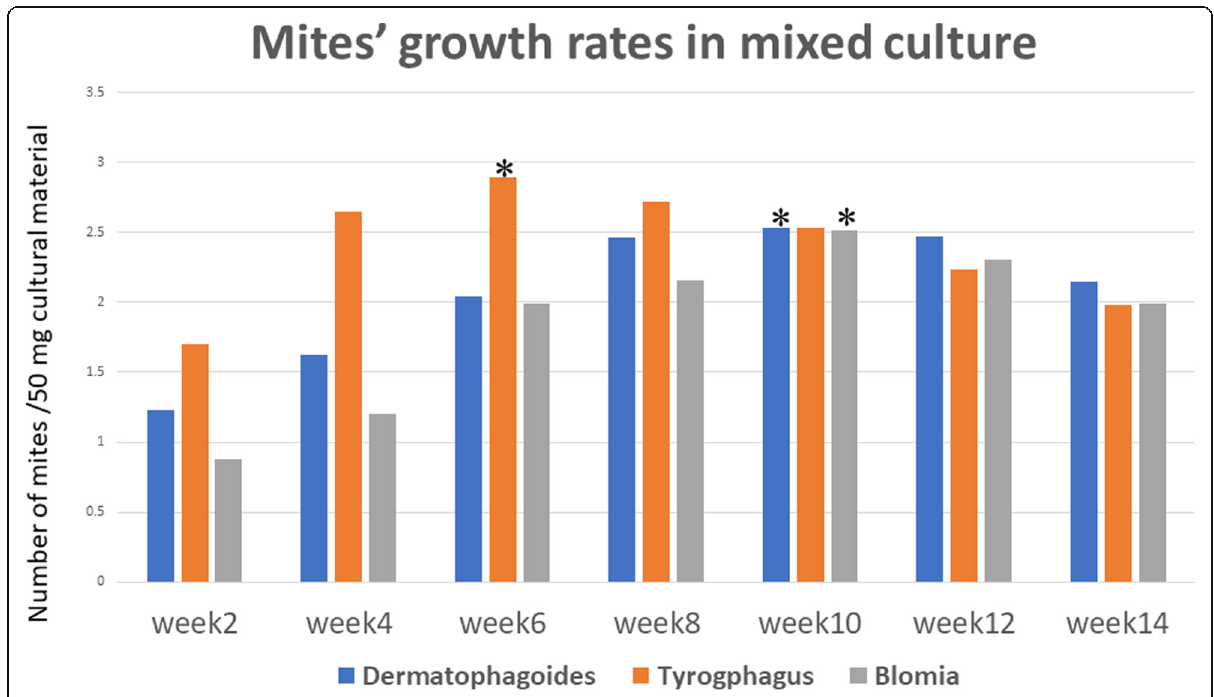
Fig. 4 Growth kinetics of Dermatophagoides , Tyrophagus , and Blomia spp. in 50-mg samples from mixed culture media (25 °C and 75% RH) along 14 weeks. Data represented as the log counts and average of 4 duplicates . *Peak growth